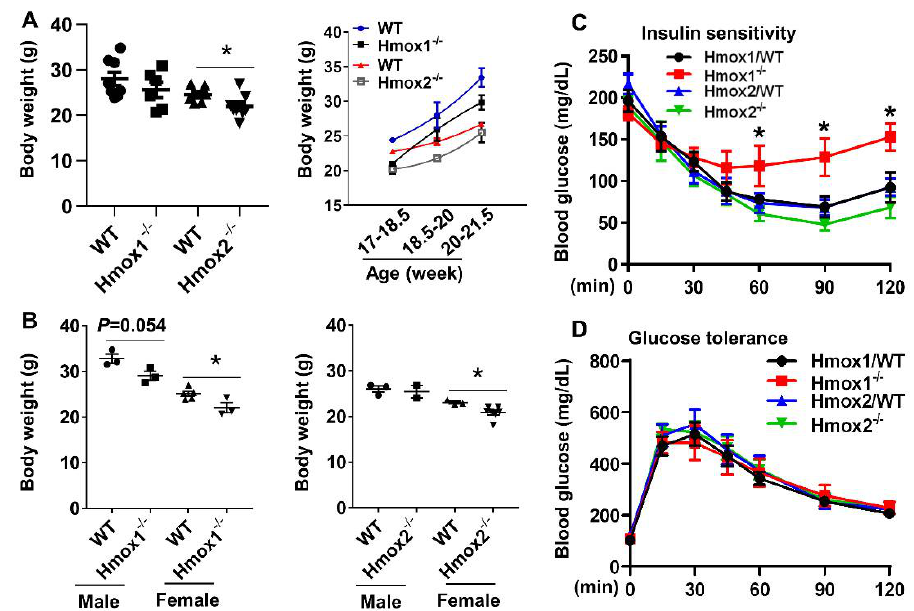
Figure 1. Insulin sensitivity was reduced in Hmox1 - / - but not in Hmox2 - / - mice. Hmox1 - / - , Hmox2 - / - mice and their wild-type (WT) littermates (4–5 months old) were used for detecting insulin sensitivity and glucose tolerance. ( A , B ) Body weight of Hmox1 - / - , Hmox2 - / - mice and their WT littermates were assessed. ( A ) Left panel denotes body weight of mixed male and female mice, while right panel denotes the changes in body weight with di ff erent ages. ( C ) Insulin (1.25 U / kg for females, 2 U / kg for males) was intraperitoneally injected, and blood glucose was measured at 0, 15, 30, 45, 60, 90, and 120 min post injection. ( D ) Glucose (2 g / kg) was intraperitoneally injected, and blood glucose was measured at 0, 15, 30, 45, 60, 90, and 120 min post injection. Data are expressed as mean ± SEM. n = 7–9. * p < 0.05 vs. corresponding WT littermates.